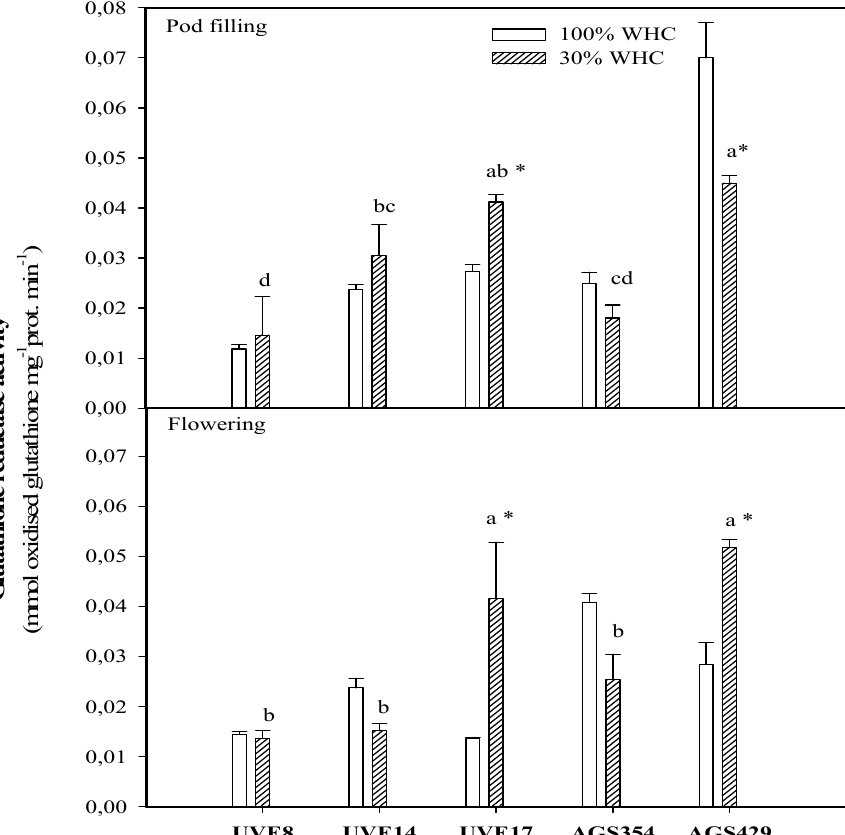
Figure 7. Glutathione reductase (GR) activity for five vegetable-type soybean cultivars subjected to two water treatments at flowering and pod-filling stages. Letters represent significant differences/similarities in GR activity for various cultivars under severe water stress at 30% water holding capacity (WHC), * represents significance at p ≤ 0.05.